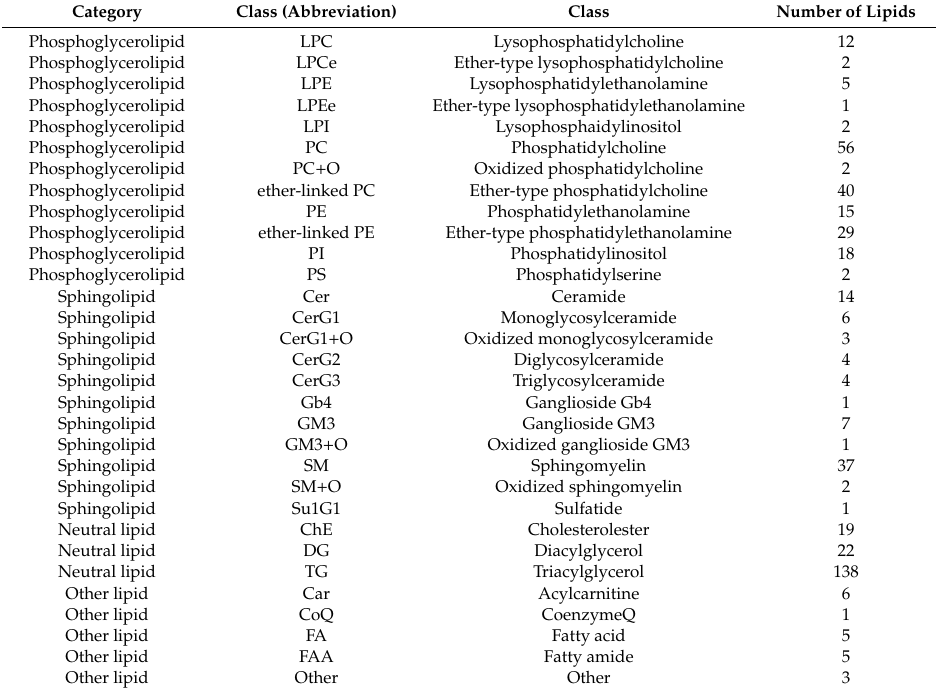
Table 2. Identified lipid classes and numbers of individual lipids.